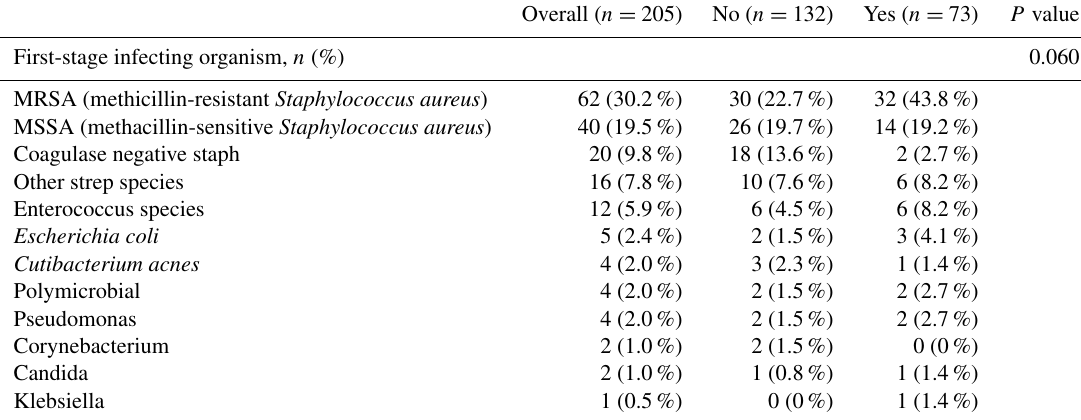
Table 2. Index surgery (first-stage) infecting organism.